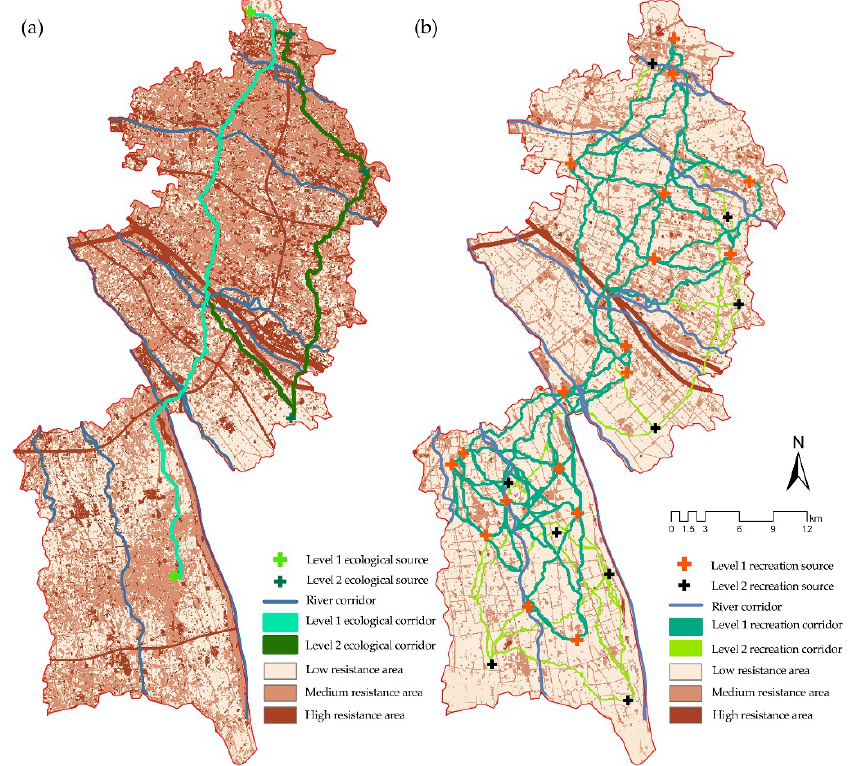
Figure 9. Distribution of corridors: ( a ) preliminary determination of ecological corridors; and ( b ) preliminary identification of recreational corridors.